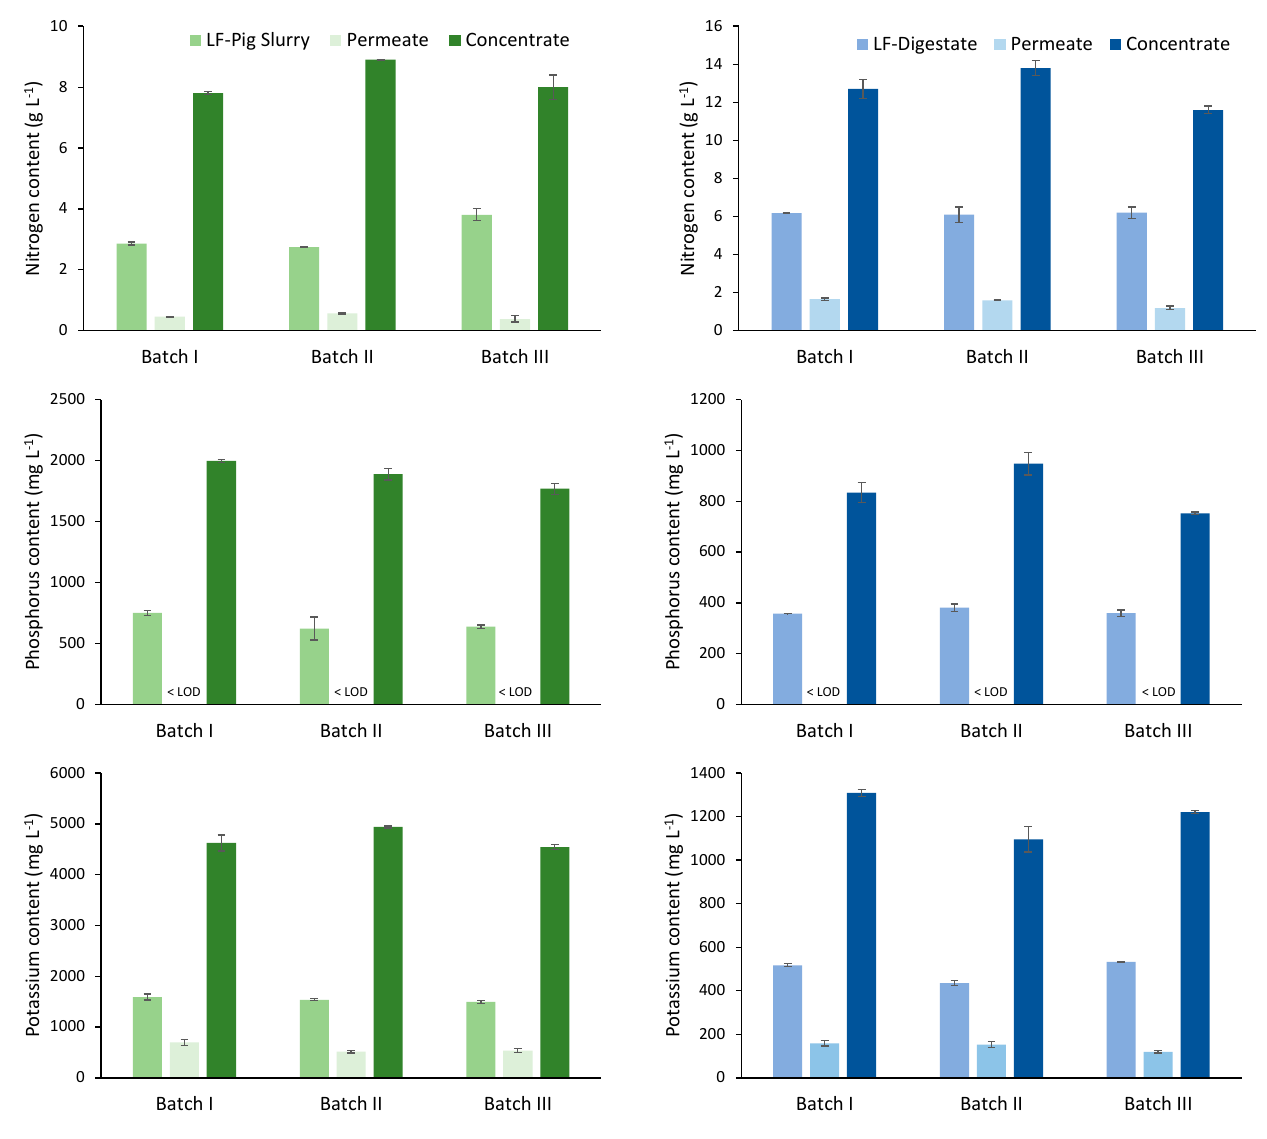
Figure 5. Concentrations of nitrogen, phosphorous and potassium detected in the feedstocks (LF-pig slurry and LF-digestate), permeates and concentrates obtained in each batch test.